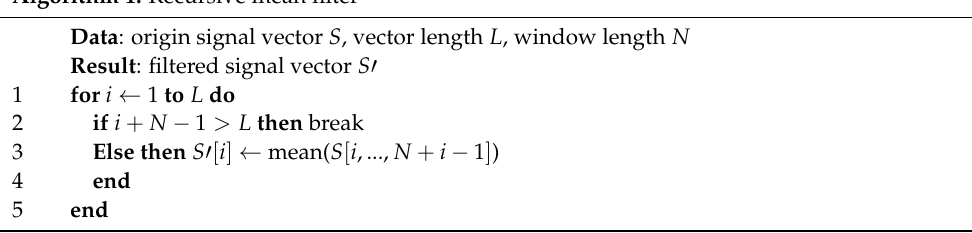
Algorithm 1. Recursive mean